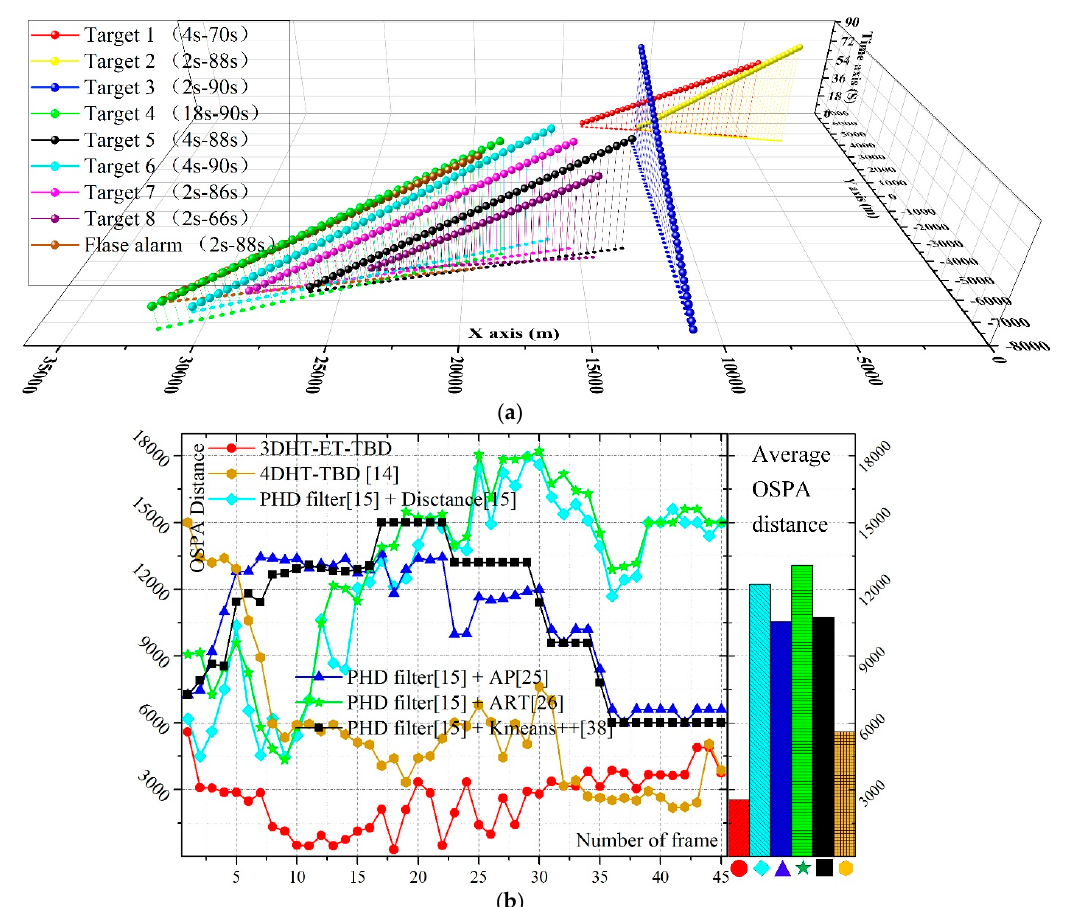
Figure 7. ( a ) The result of the 3DHT-ET-TBD. ( b ) The OSPA distance of the methods at each scan.